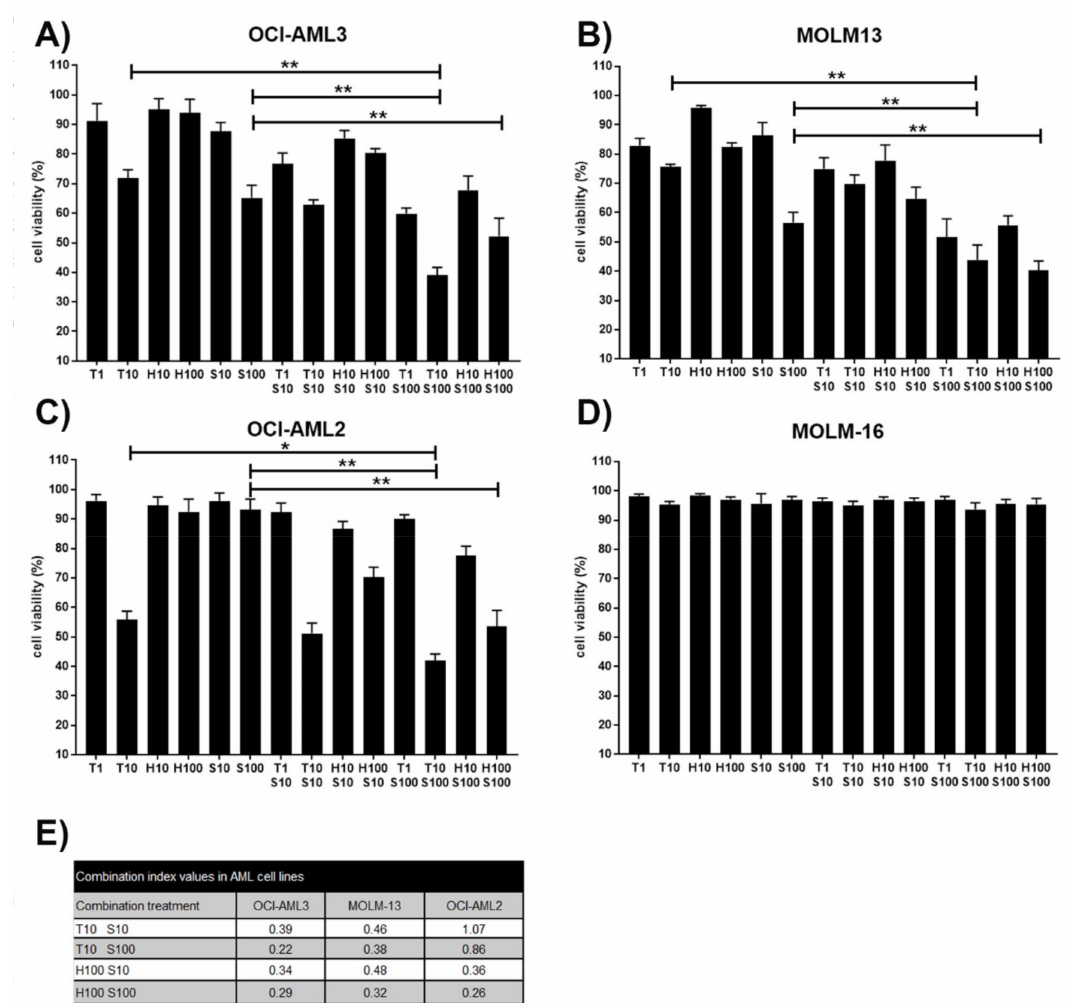
Figure 1. Susceptibility of AML cells to S63845, HDM201, and trametinib. Cell viability in AML cell lines OCI-AML3 ( A ), MOLM-13 ( B ), OCI-AML2 ( C ), and MOLM-16 ( D ) treated for 20 h with increasing dosages 1nM, 10nM, and 100nM of S63845 (S), HDM201 (H), and trametinib (T) alone or in combination. All values are in reference to mock treated cells ( = 100% viability). Combination index values ( E ) were calculated on ComboSyn software. Combinatorial e ff ects were interpreted to correspond to strong synergism for CI = 0.1–0.3; distinct synergism for CI = 0.3–0.7, mild synergism for CI = 0.7–0.9; additive for CI = 0.9–1.1. Significance is denoted for p < 0.05 (*); p < 0.005 (**). Synergistic e ff ects on cell viability were detected in the combination treatments with S63845 and trametinib in OCI-AML3 and MOLM-13 cells and in the combination treatments with S63845 and HDM201 in OCI-AML2, OCI-AML3, and MOLM-13 cells with combination indexes of 0.2 to 0.5. Synergism was calculated to be strong in OCI-AML3 cells for the combination of 100nM S63845 and 10nM trametinib or 100nM HDM201 with combination index values of 0.2 to 0.3. In direct comparison trametinib had hundredfold greater potency compared to HDM201, as 1nM trametinib and 100nM HDM201 had the same e ff ect on MOLM-13 cells. Hence, the later studies in malignant cells of hematological patients were focused on the combination treatment with trametinib and